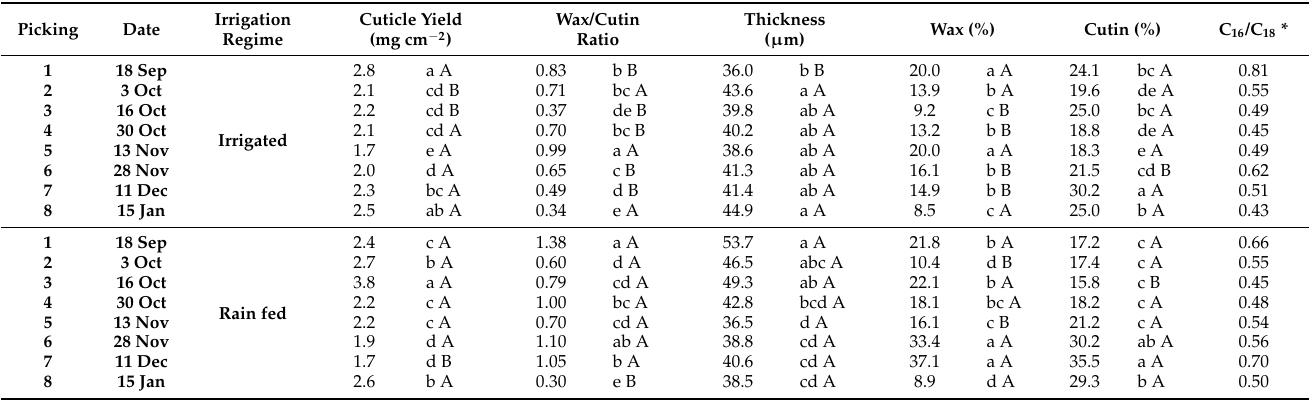
Table 3. Total cuticle amounts and thickness, cuticular wax and cutin percentages, and wax-to-cutin ratios in fruit cuticles during ripening of irrigated and non-irrigated ‘Arbequina’ olives.